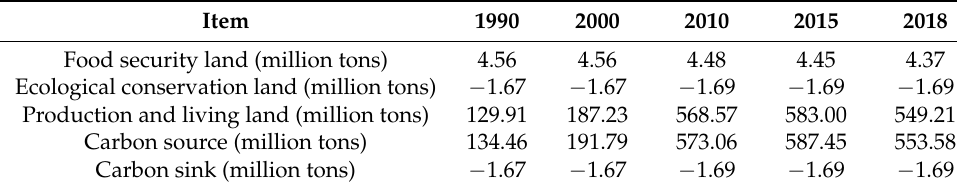
Table 5. Change in carbon storage in Henan Province, from 1990 to 2018.